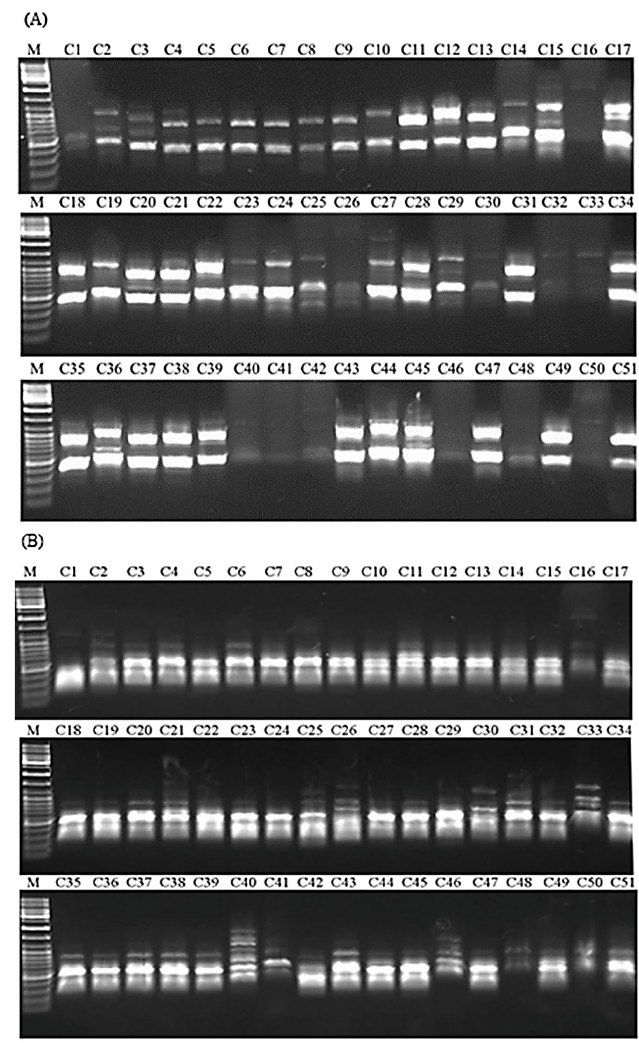
Fig. 1: RAPD and ISSR amplification profiles of 50 rice cultivars and a com- mercial rice cultivar generated using RAPD primer A01 in panel